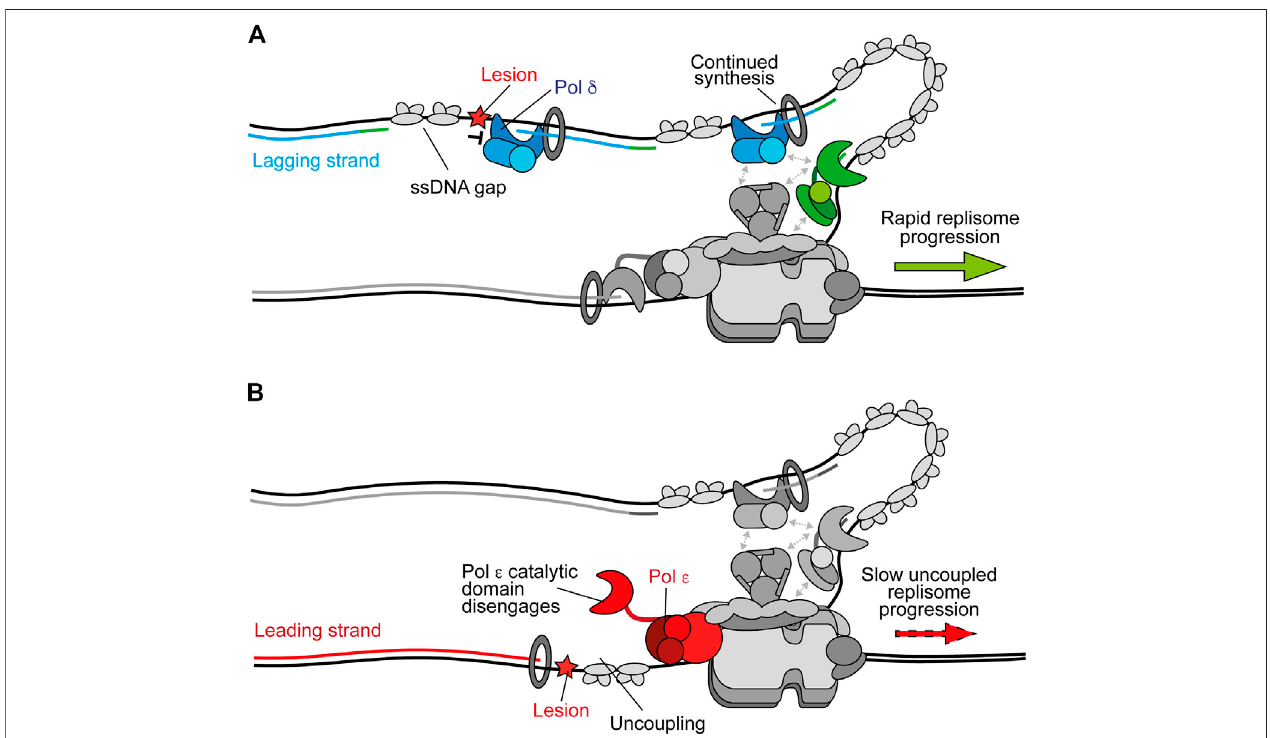
FIGURE 2 | Polymerase stalling on the leading and lagging strands. (A) Stalling of Pol δ at a DNA lesion during synthesis of one Okazaki fragment does not affect synthesis of subsequent fragments or ongoing replication fork speeds. Instead, a persistent ssDNA gap is formed. Synthesis by Pol δ and Pol α are shown in blue and greenrespectively.Otherreplisomecomponentsareshowningrayforclarity (B) StallingofPol ε byaDNAlesionduringleading-strandsynthesiscausesuncouplingdue to disengagement of the fl exible catalytic domain from the nascent strand and PCNA. Here, template unwinding and lagging-strand synthesis continue but at a much-reduced rate, resulting in the generation of RPA-coated ssDNA on the leading strand. Synthesis by Pol ε is shown in